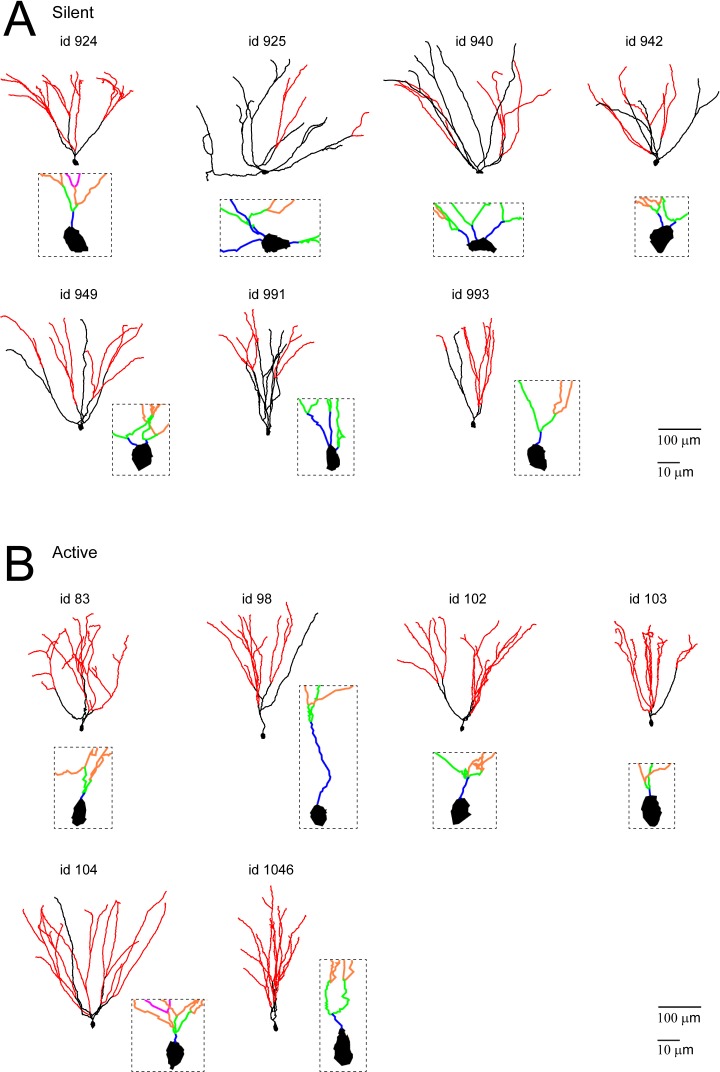
Morphological reconstructions of GCs recorded and labeled in freely moving rats.(A, B) Morphological reconstructions of silent (A) and active (B) GCs, recorded in freely moving rats. Dendritic branch orders 1–3 are indicated in black, while high-order branches (≥4) are indicated in red (same color-code as in Figure 4A). The insets show close-up magnifications of the soma and the proximal dendrites of each cell (first-order dendrites are in blue, second-order in green, third-order in orange and fourth-order in magenta). Scale bars=100 µm for the low magnification and 10 μm for the insets. Cell ids are indicated.